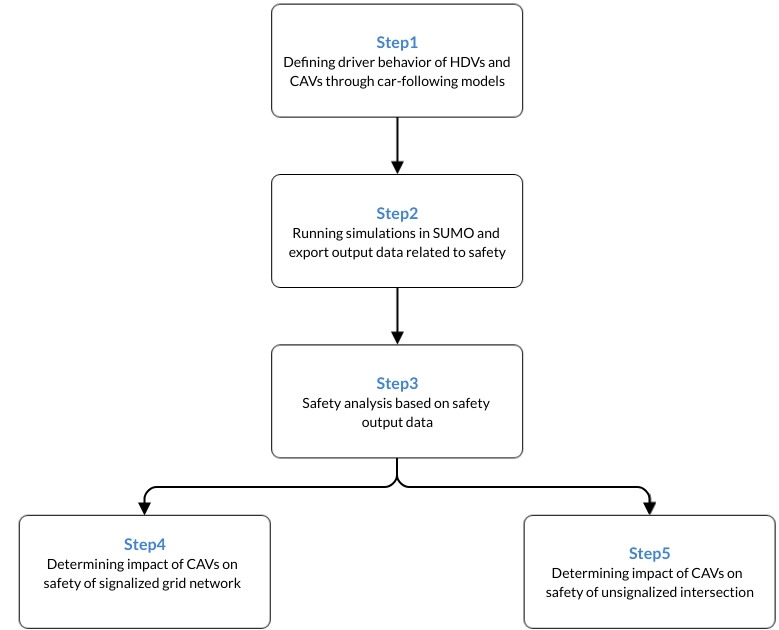
Figure 1. Study framework.